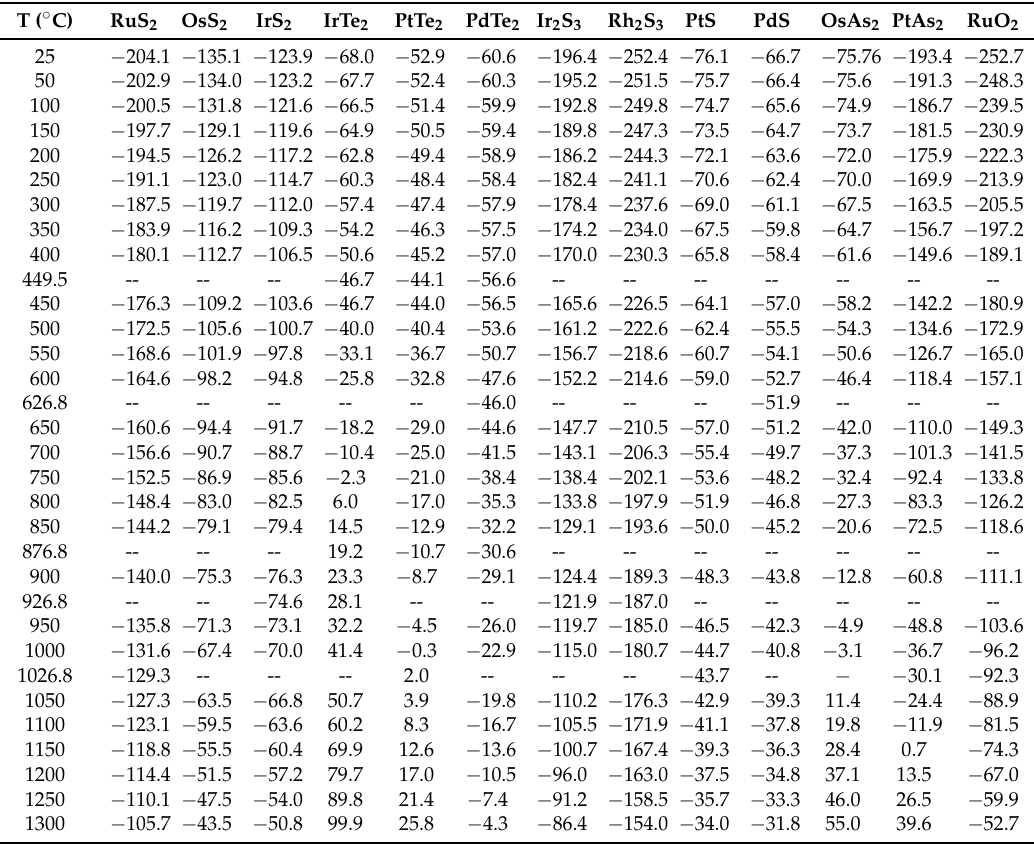
Table 4. Extrapolation of the calculated free energy values at standard stage ( ∆ f G ˝ ) (Table 1) to a wide range of